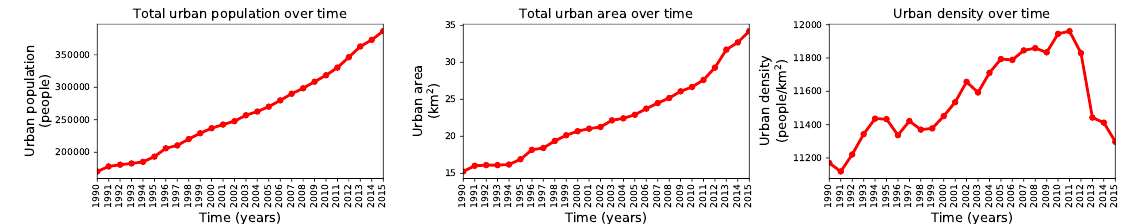
Figure 19. Diagnostic graphs of the geographic area of interest masked by the administrative division of Valledupar. ( Left ) total urban population. ( Center ) total urban area. ( Right ) urban